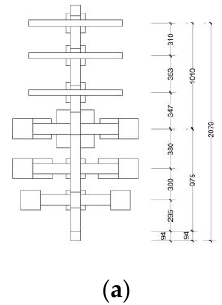
Figure 7. CAD drawing of bucket arch of the Niuwang Temple Stage. ( a ) Plane. ( b ) Facade. ( c ) Section.